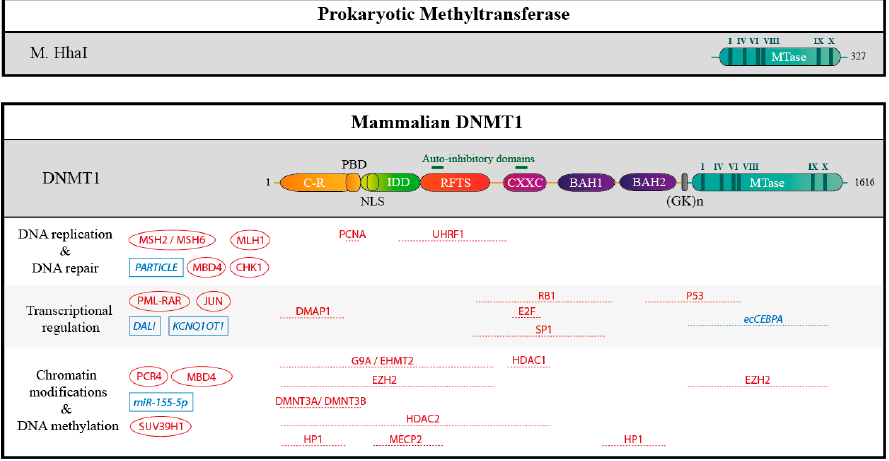
Figure 4. Schematic structure of the prokaryotic methyltransferase M. HhaI, compare to DNMT1 and partners. The human DNMT1 contains 1616 amino acids residues. The catalytic methyltransferase domain (MTase, in blue) is very similar to that of the prokaryotic methyltransferase M. HhaI and harbors highly conserved motifs (I-X, in dark blue). In addition, DNMT1 harbors a charge-rich (C-R) domain containing the proliferating cell nuclear antigen (PCNA) binding domain (PBD), an intrinsically disordered domain (IDD) with a nuclear localization sequence (NLS), a replication foci target sequence (RFTS), a zinc finger domain (CXXC), and two bromo-adjacent homology domains (BAH 1/2). The catalytic and the regulatory domains are connected by a series of Gly-Lys repeats. Auto-inhibitory domains are highlighted in green. In addition, some interacting proteins and RNAs are represented: if they are known, mapped interaction domains are indicated. Partners with unknown binding sites are shown on the left. Proteins are depicted in red, RNAs in